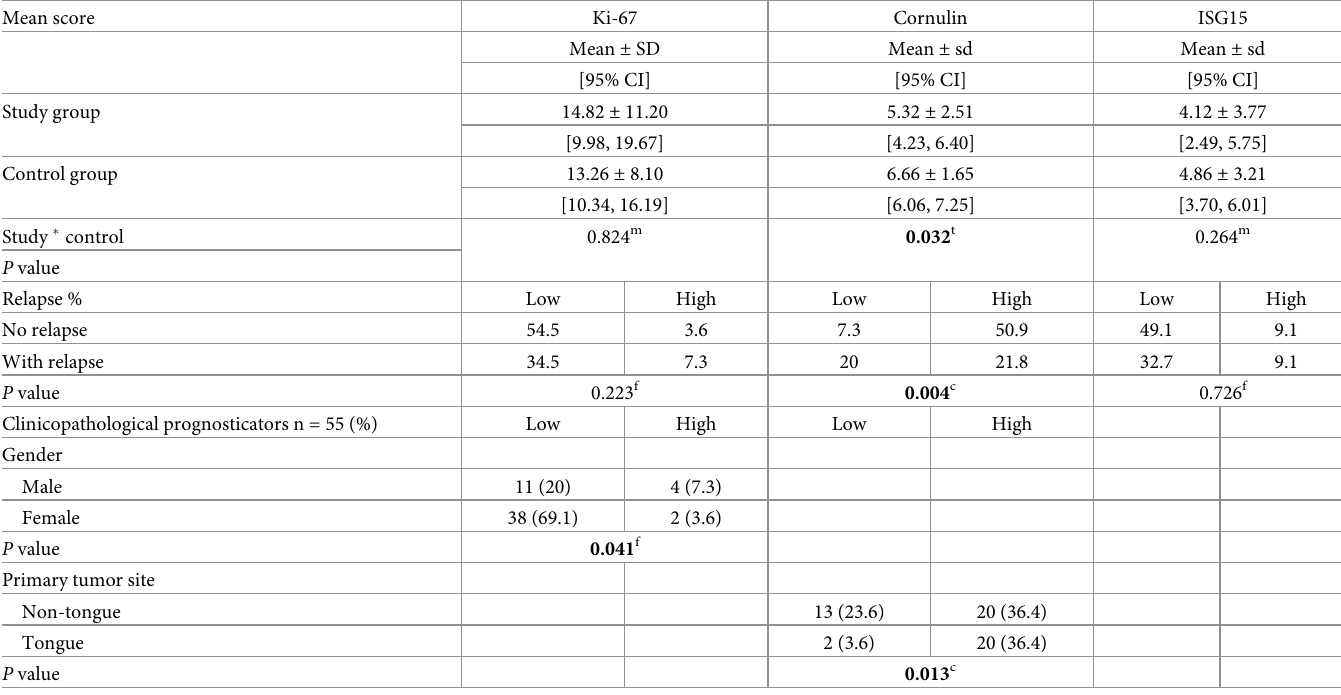
Table 3. Expression of Ki-67, Cornulin and ISG15 in surgical margins, and clinicopathological prognosticators.